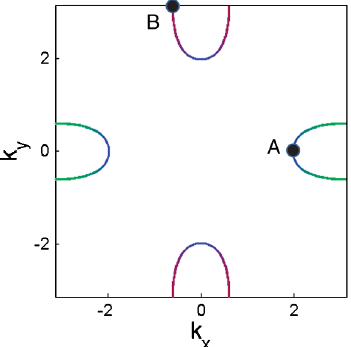
FIG. 1. The Fermi-surface setup used to represent the chalco- genides in the mean-field calculation. Colors indicate the orbital ), green ( d ), and blue ( d ). The areas of components: red ( d xz yz xy blended colors are a reflection of hybridization between orbitals. The A and B points are auxiliary labels used in Figs. 2, 3, and 6.